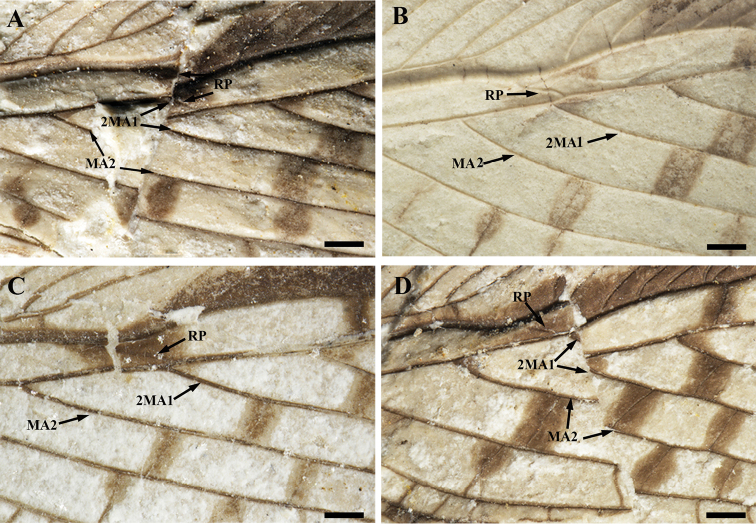
Details of the middle part of the forewings of Parelcana
pulchmacula sp. nov., showing the variable location of the fusion point of RP and MA1 in the forewing. ACNU-ORT-NN2016035 BCNU-ORT-NN2016036 C holotype, CNU-ORT-NN2016041 DCNU-ORT-NN2016042. Scale bar: 0.5 mm.